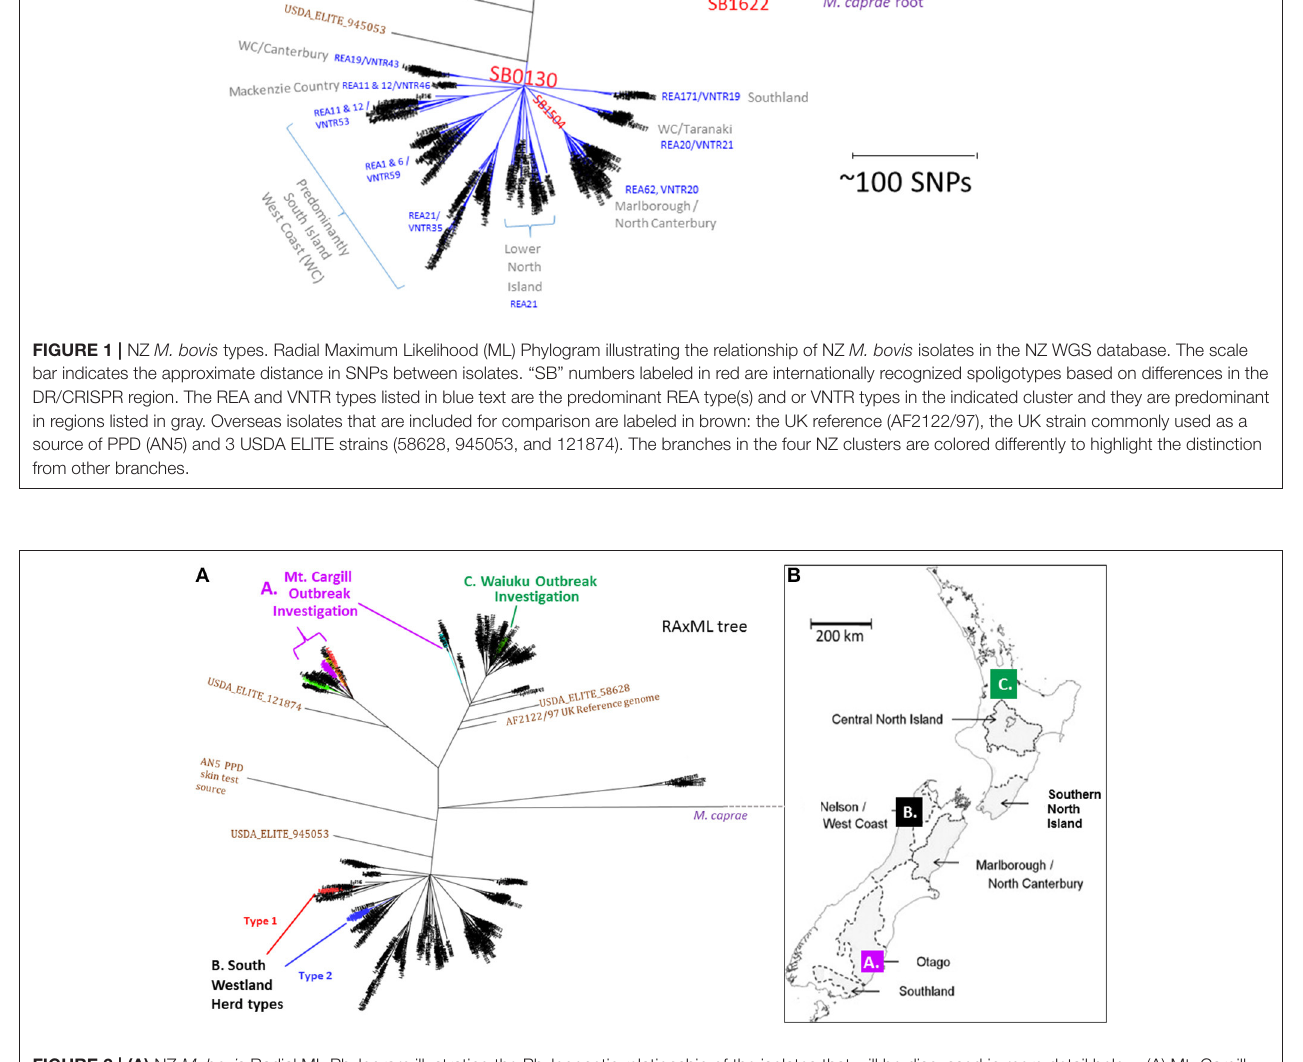
Frontiers in Veterinary Science |